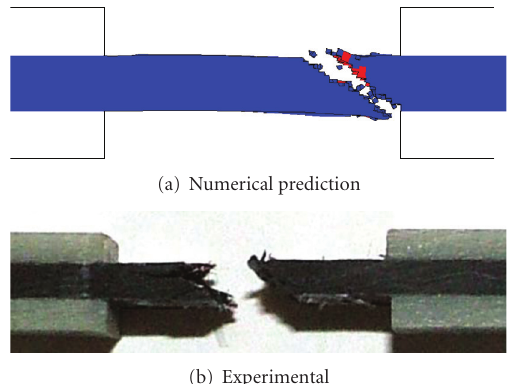
Figure 25: Comparison between predicted and experimental failure locations for the compression test in the transverse direction.